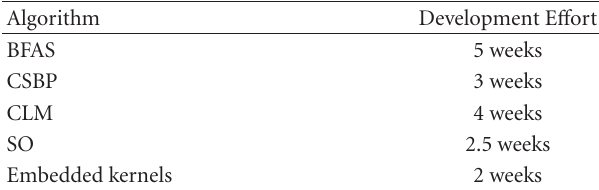
Table 7: Development e ff ort.